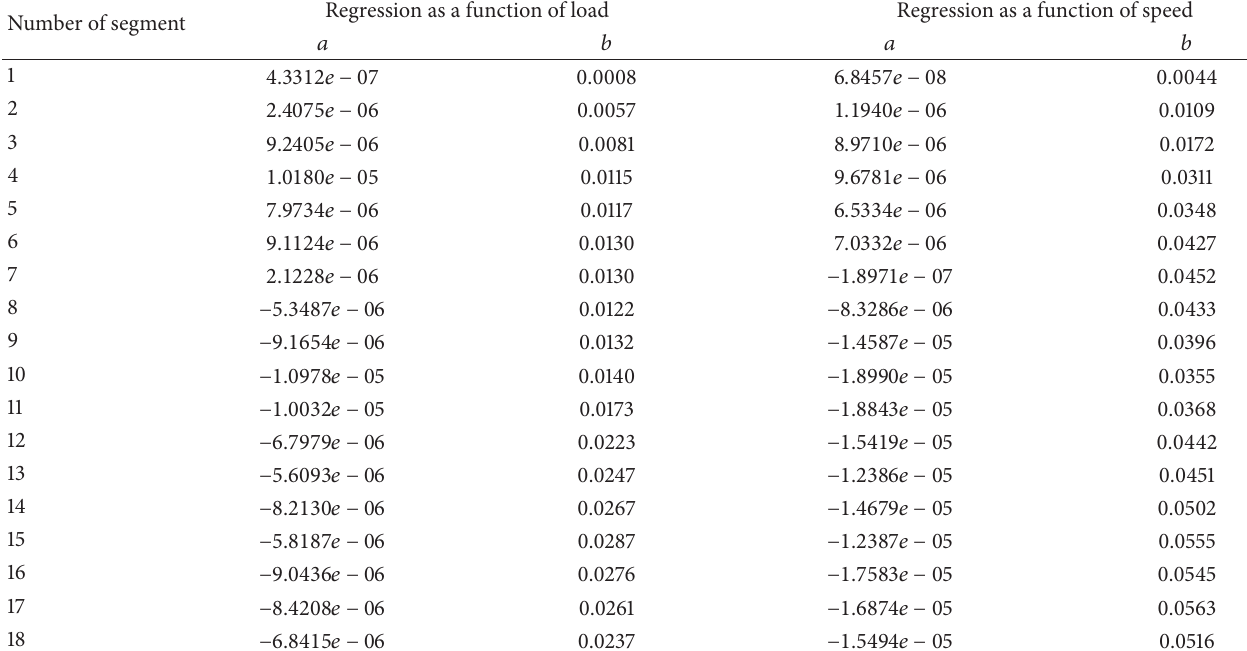
Table 2: Regression parameters a and b for RMS